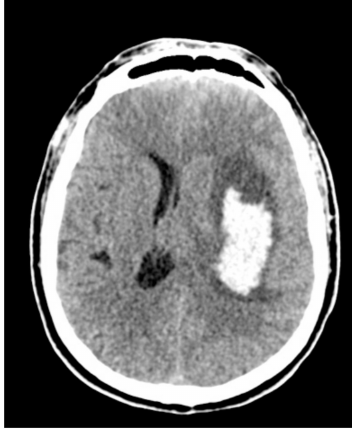
Figure 2. The preoperative aspect of a deep-seated intracerebral hemorrhage